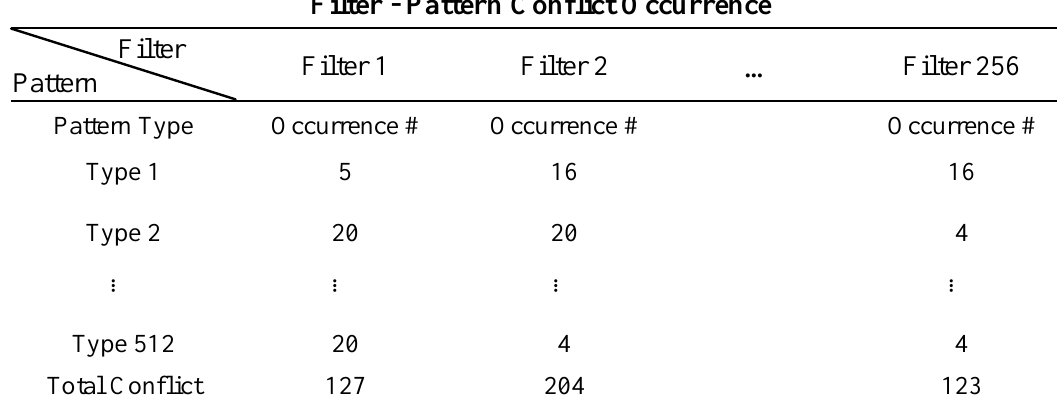
Table 3. Pattern-filter conflict